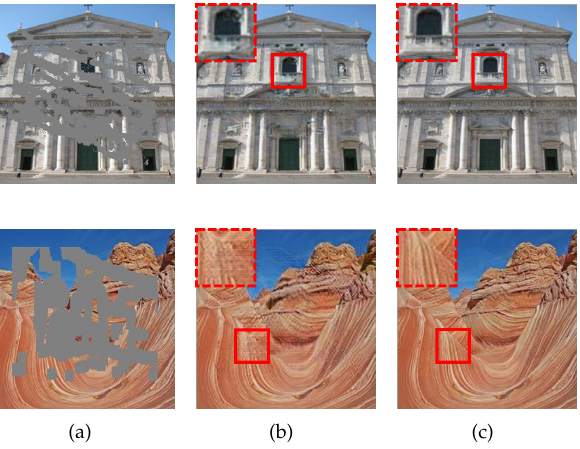
Figure 11. Qualitative results for the ablation study on the collaborative effect between inpainting stages. The corruption rates, from top to bottom, are 25.0% and 38.4%, respectively. ( a ) Input images. ( b ) Resulting images when the filled regions are switched off. ( c ) Resulting images when the filled regions are switched